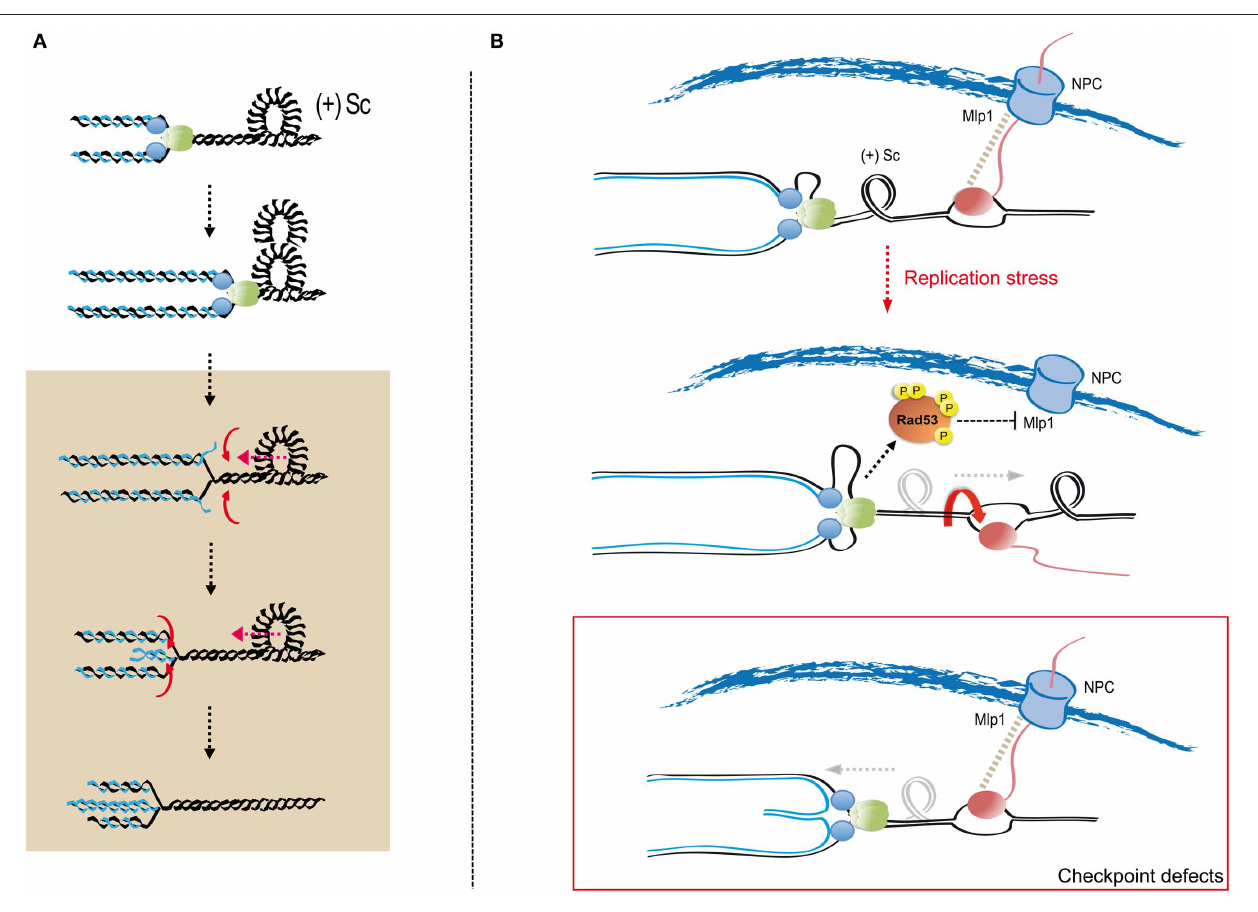
FIGURE 3 | Replication fork reversal and checkpoint-mediated topological simplification at transcribed regions. (A) DNA double helix unwinding during replication generates torsional stress that can accommodate as positive supercoiling ( + Sc) ahead of replication forks. Progressively accumulating positive supercoiling provides the driving force for replication fork reversal; particularly upon the dissociation of replisome components from fork DNA. Positive supercoiling can be re-accommodated by re-winding of the parental strands, which results in the regression of the fork branching point and the extrusion of newly synthesized strands (in blue). Newly synthesized DNA strands annealing, driven by sequence homology, leads to the formation of four-way cruciform junctions known as reversed forks or chicken feet . Reversed forks can branch-migrate due to further positive supercoiling-driven parental strand re-annealing. Replisome components are represented as green and blue circles. The gray box delimits aberrant transitions leading to fork reversal. (B) Activation of